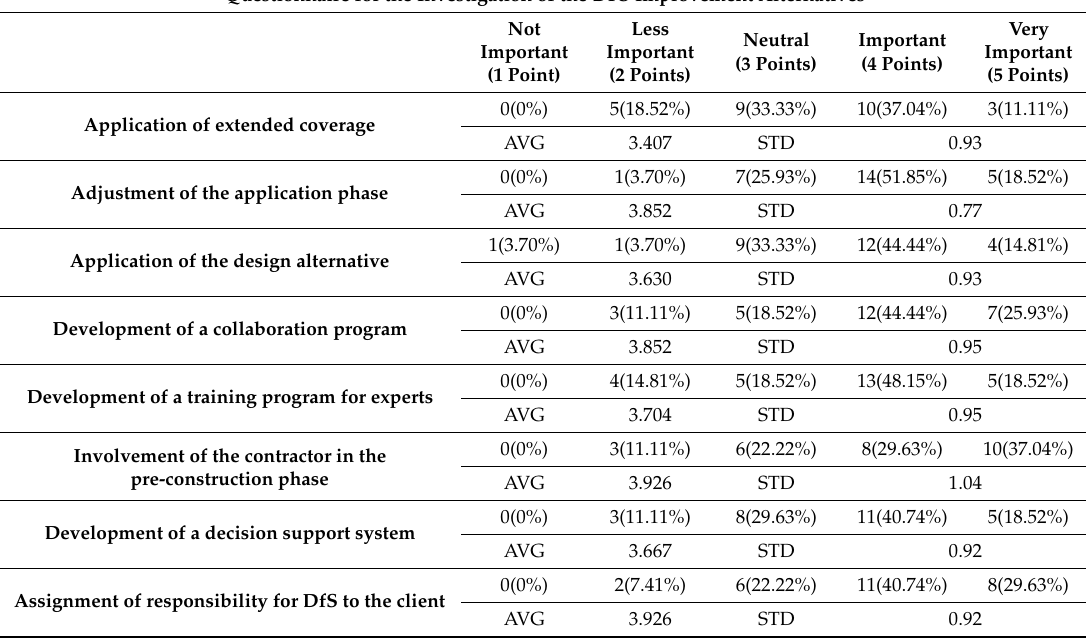
Table 3. Investigation of the DfS improvement